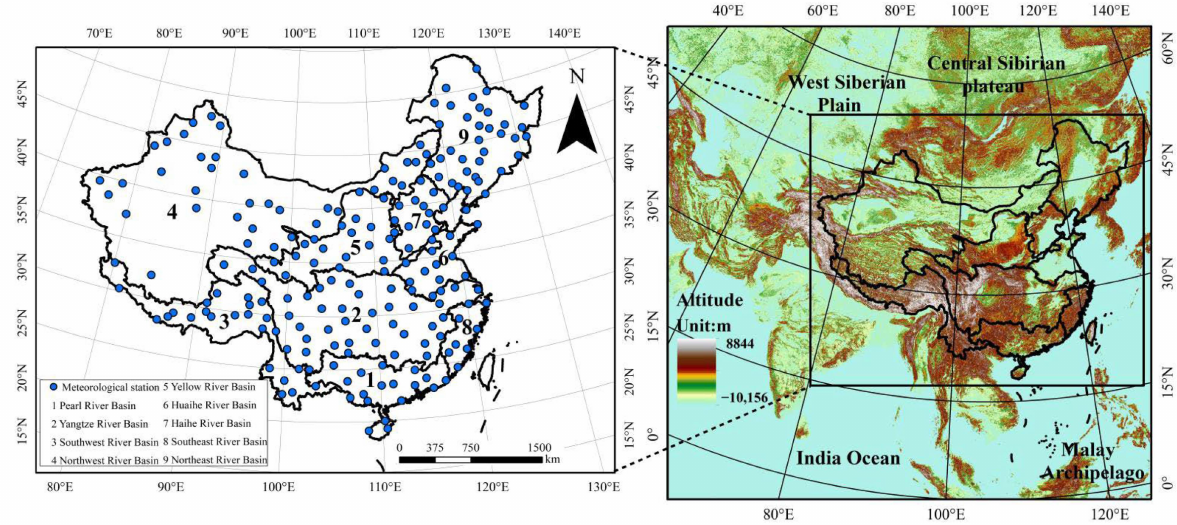
Figure 1. Distribution of nine river basins and meteorological stations in